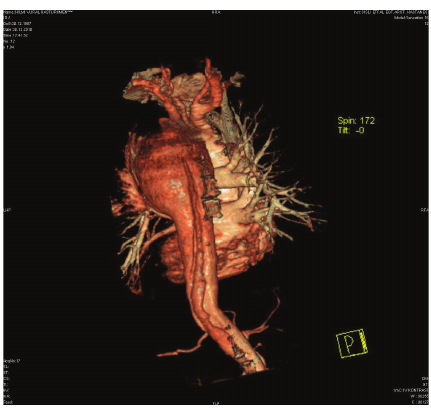
Figure 4: 3D volume rendering image, clearly delineating the